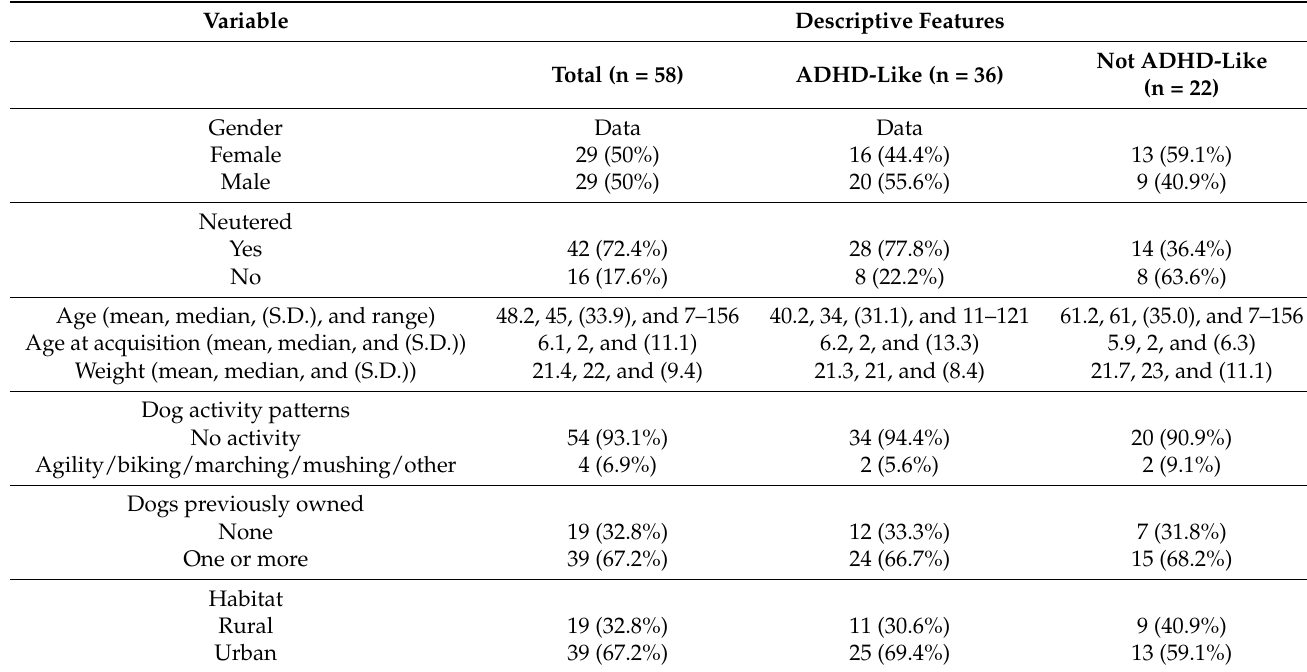
Table 2. Descriptive analysis of the studied dog population according to ADHD-like clinical